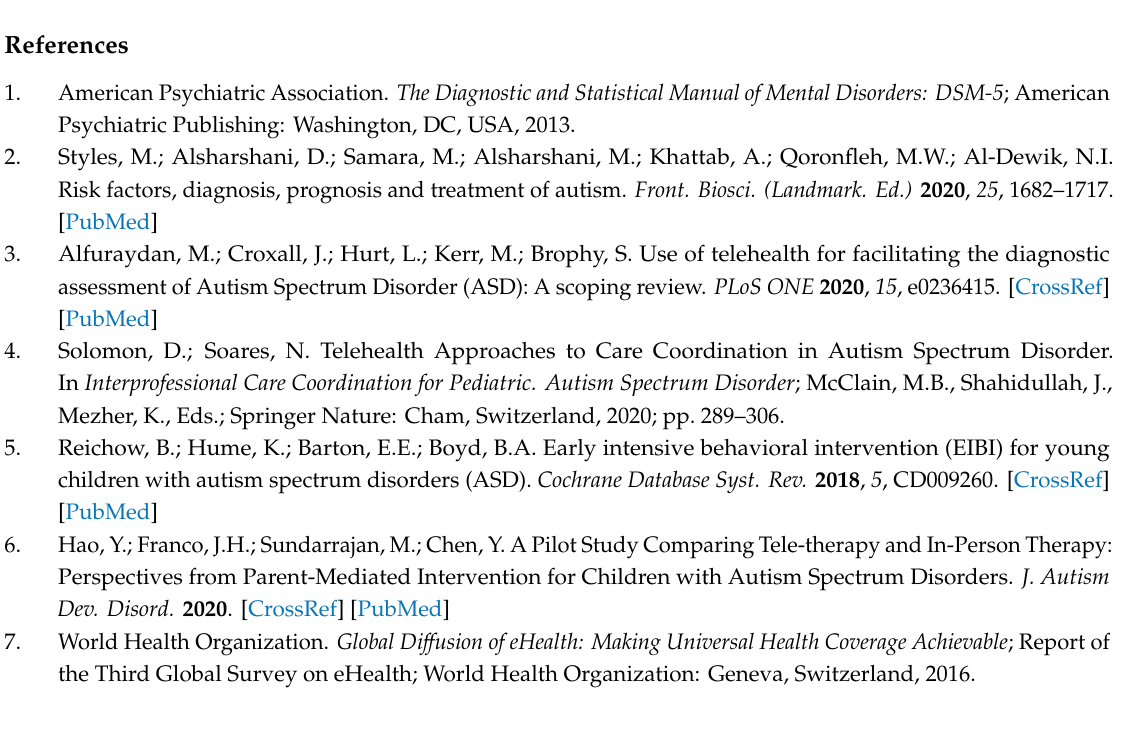
Table S1. Raw Data of Analyzed Participants, Tables S2–S9: Pre- and postintervention results for each participant. Author Contributions: Conceptualization, F.M., D.V. and G.P.; methodology, F.M., L.R., D.V. and G.P.;